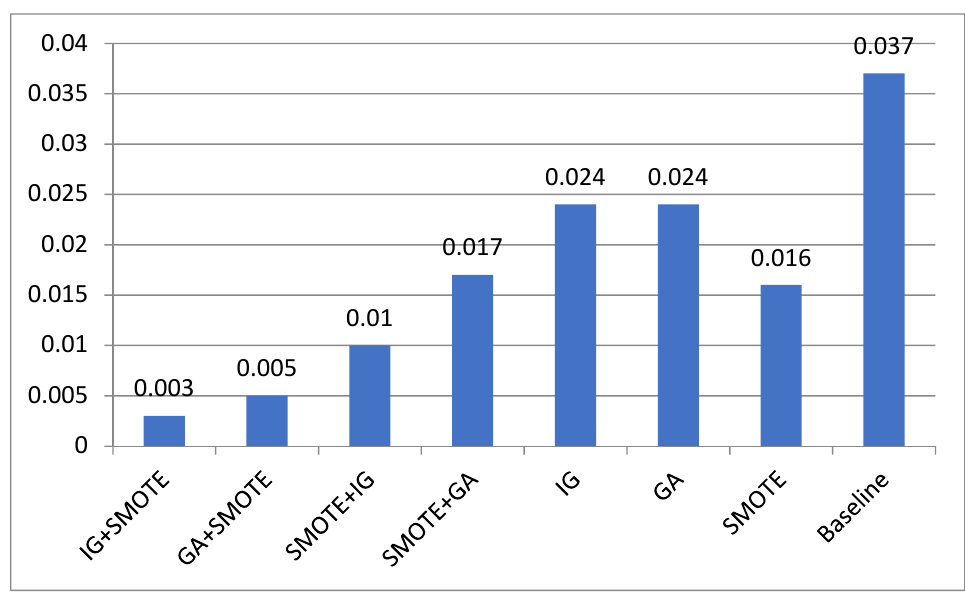
Figure 1. AUC rates of different approaches over the KDD Cup 2008 breast cancer dataset.